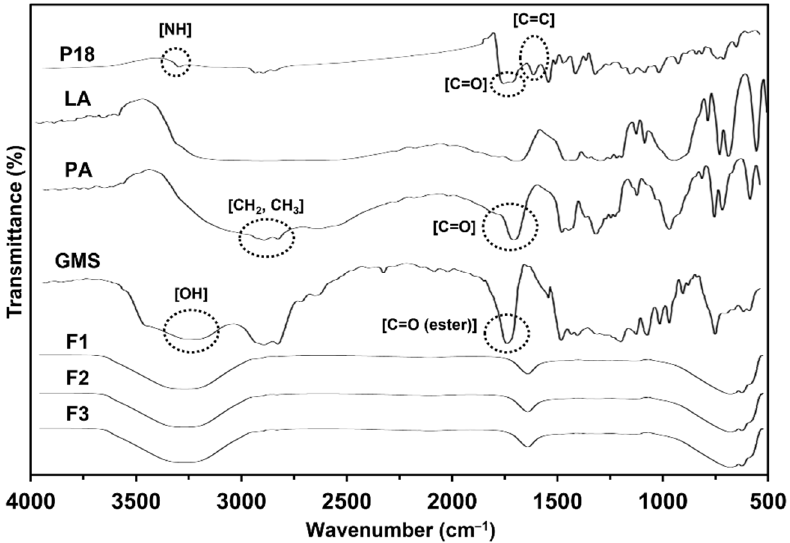
Figure 5. FTIR-ATR spectroscopy overlay spectra of solid lipid nanoparticles. Pure P18; LA; PA; GMS; F1: SLNs prepared using LA; F2: SLNs prepared using PA; F3: SLNs prepared using GMS. P18, purpurin-18; LA, lauric acid; PA, palmitic acid; GMS, glycerol monostearate. Table 4. Infrared absorption (cm − 1 ) of both P18 structural components (NH; C=O; and C=C stretching) and lipid structural components (OH; CH 2 , CH 3 ; C=O (ester) stretching) in P18, lipids (LA, PA, and GMS), and formulations (F1, F2, and F3).